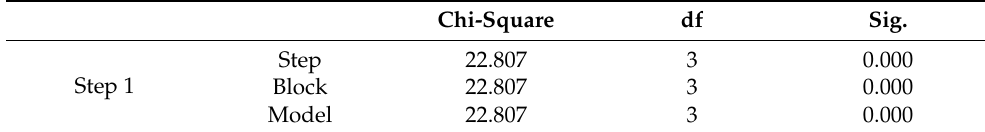
Table 13. Omnibus tests of model coefficients.